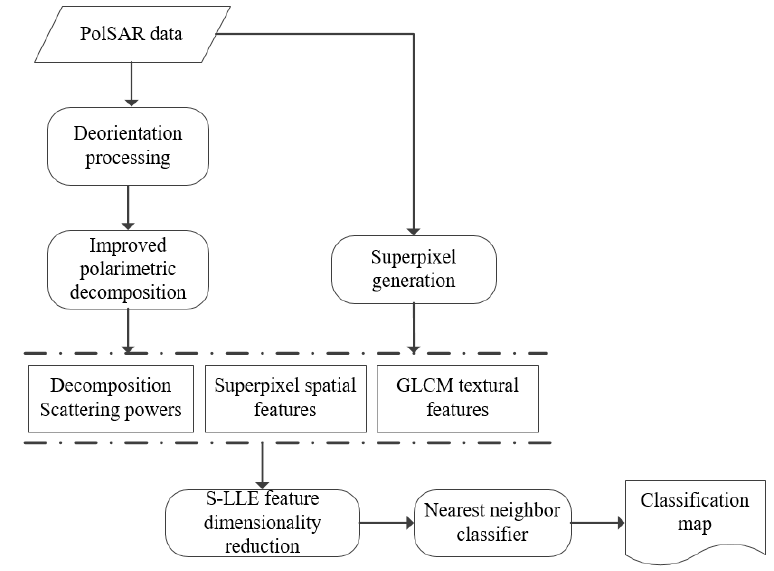
Figure 5. The whole diagram of the proposed methodology.